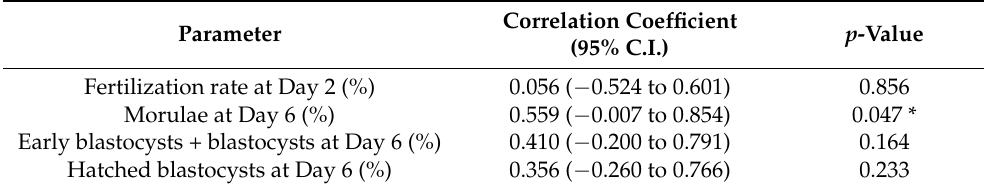
morulae at day 6 post-fertilization ( r = 0.559; p = 0.047) were found, but not between te-